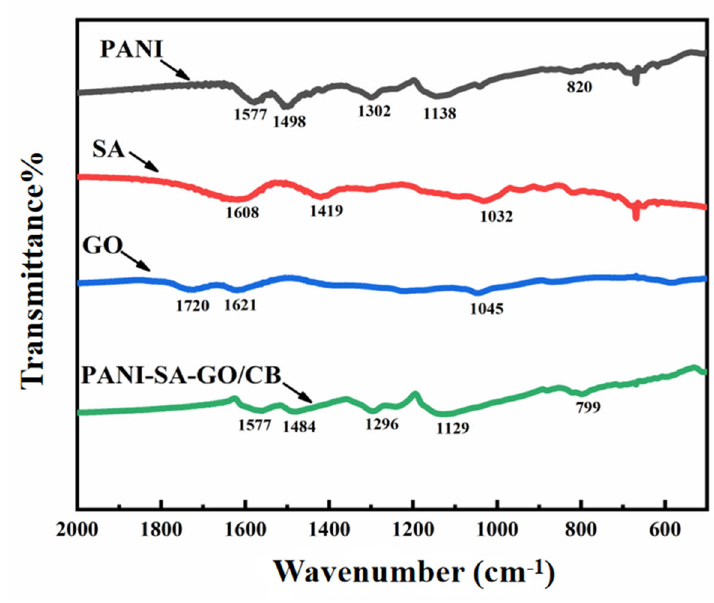
Figure 2. FTIR spectra of di ff erent modi fi ed materials.